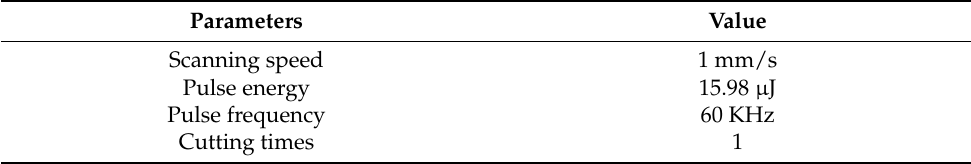
Table 2. Constant process